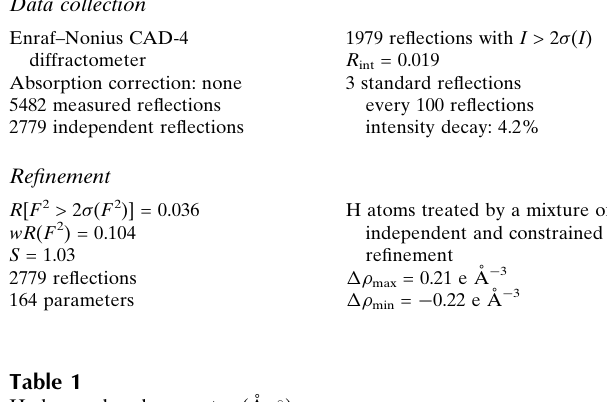
Hydrogen-bond geometry (A˚ , (cid:2)